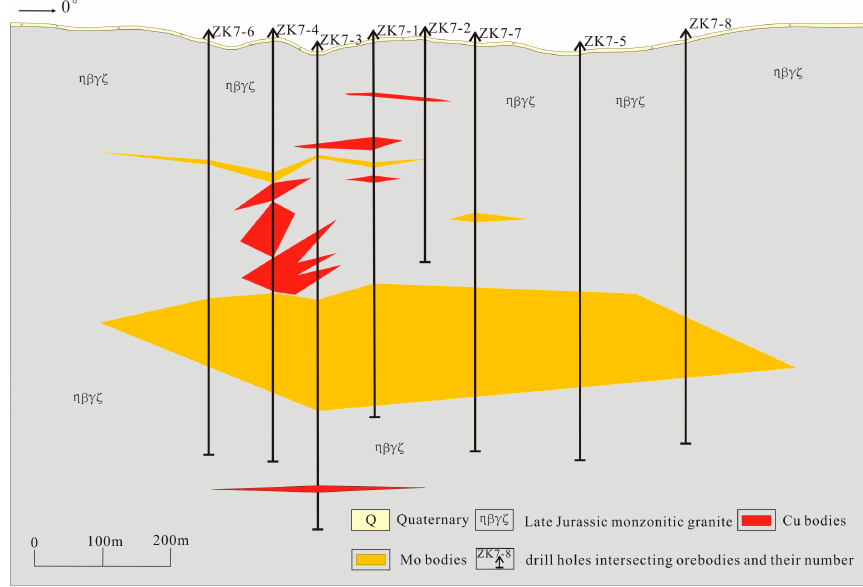
Figure 2. Geological cross-section of Line No. 7 through the Chang’anbu Cu–Mo ore deposit (modified after [8]).